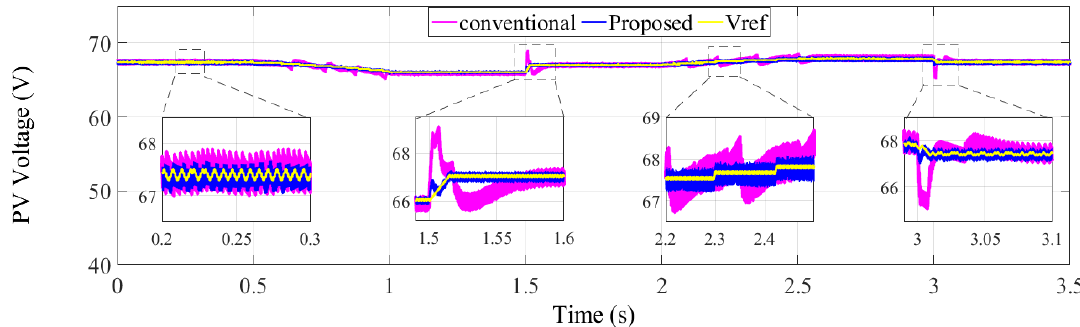
Figure 12. Simulation results of grid-tied PV system with the proposed control scheme; under irradiation changes. ( a ) PV Voltage; ( b ) PV Current; ( c ) PV Power; ( d ) DC−Link Voltage; ( e ) Id Current and ( f ) Iq Current.